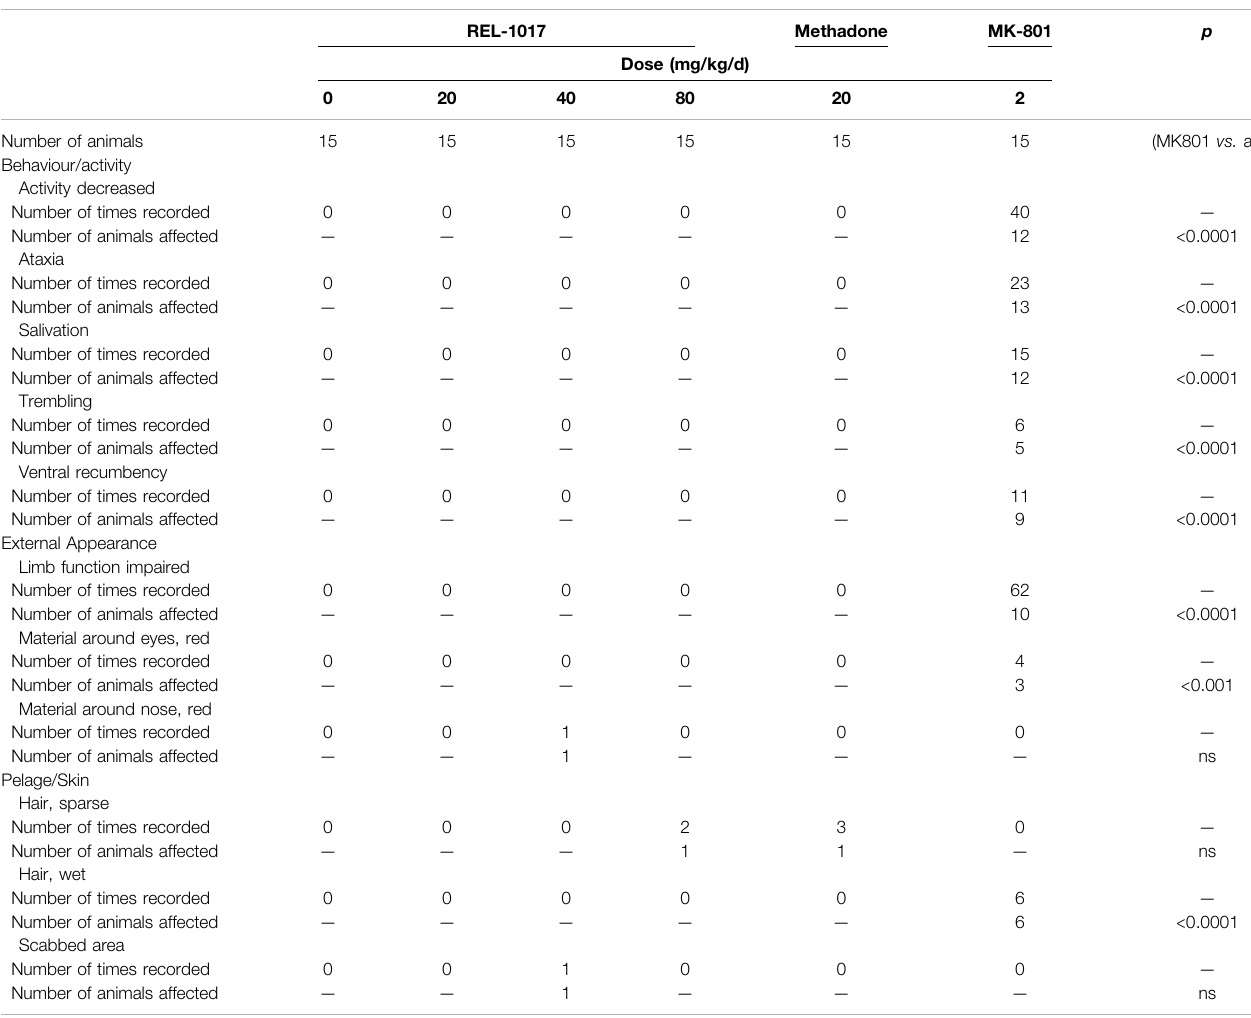
TABLE 2b | Clinical observations — Male rats.